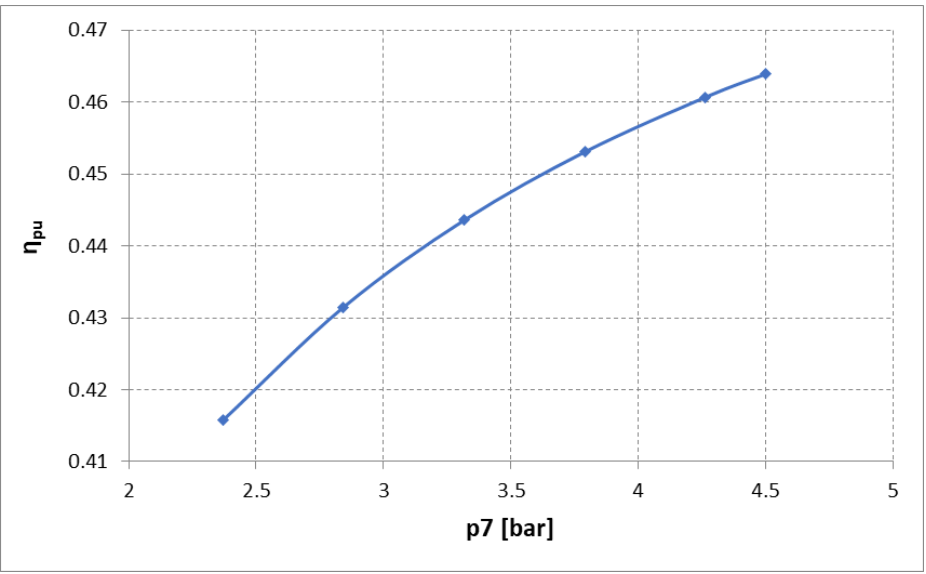
Figure 5. Power unit efficiency as a function of pressure p 7 for 2500 rpm and 17 bar pme.